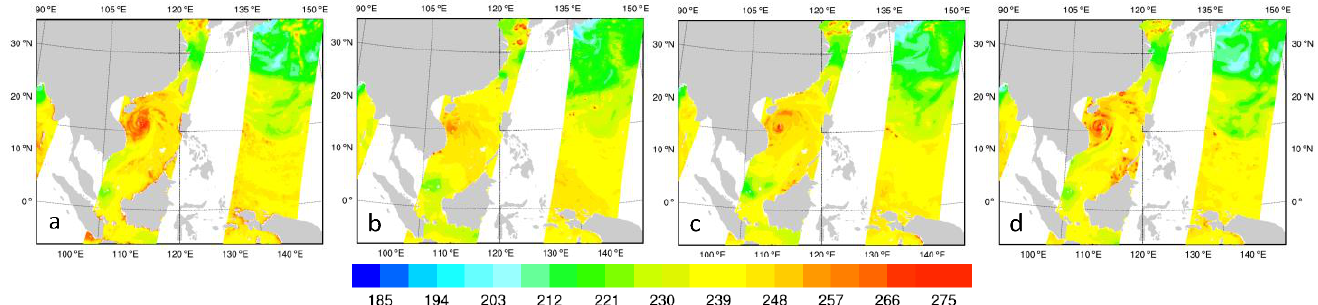
Figure 5. The distribution of channel 5 observations: ( a ) before quality control; ( b ) after quality control.